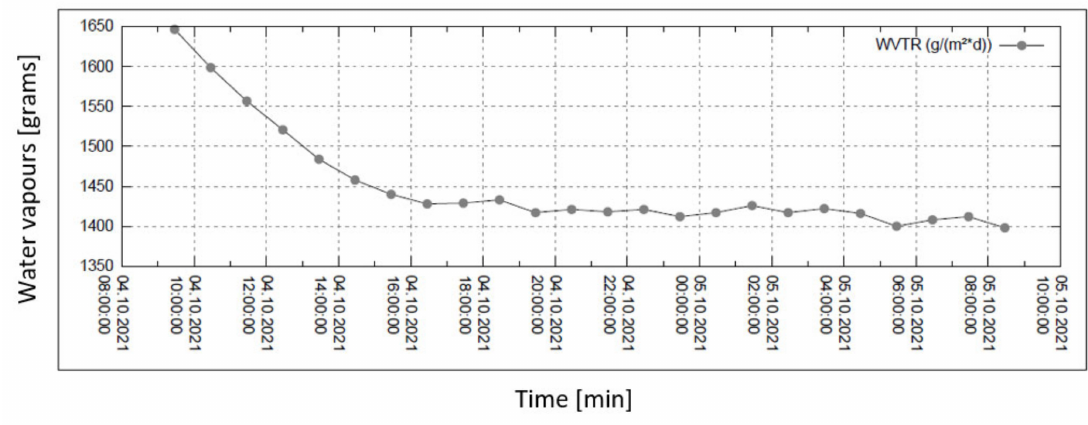
Figure 9. Permeability of water vapour over 24 h with 90% external